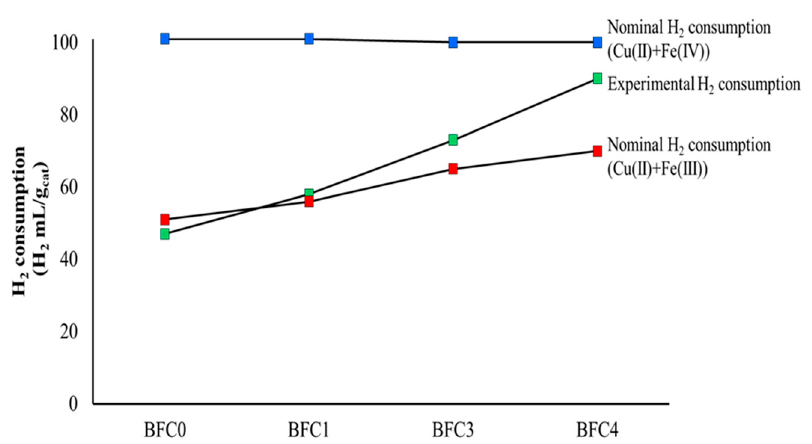
Figure 7. H 2 consumption (mL/g of catalyst).